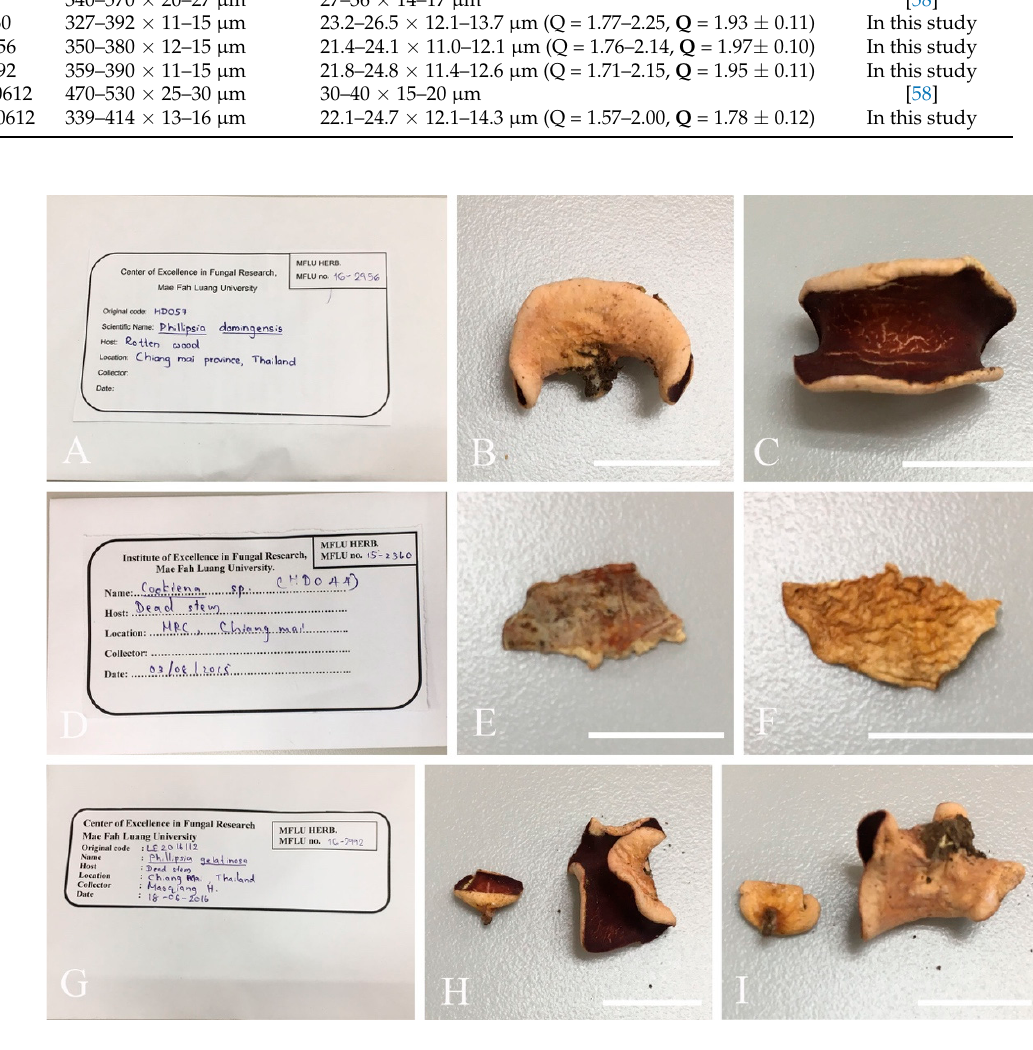
Figure 15. Herbarium materials of Phillipsia gelatinosa . ( A – C ) MFLU 16 ‐ 2956 (? holotype). ( D – F ) MFLU 15 ‐ 2360 (? holotype). ( G – I ) MFLU 16 ‐ 2992. Scale bars ( B , C , E , F , H , I ) = 2 cm.